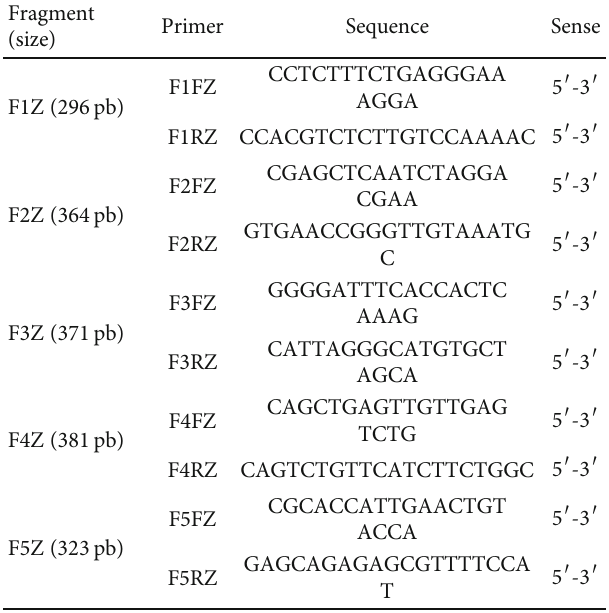
Table 1: Primers used for TCR ζ -cDNA ampli fi cation.